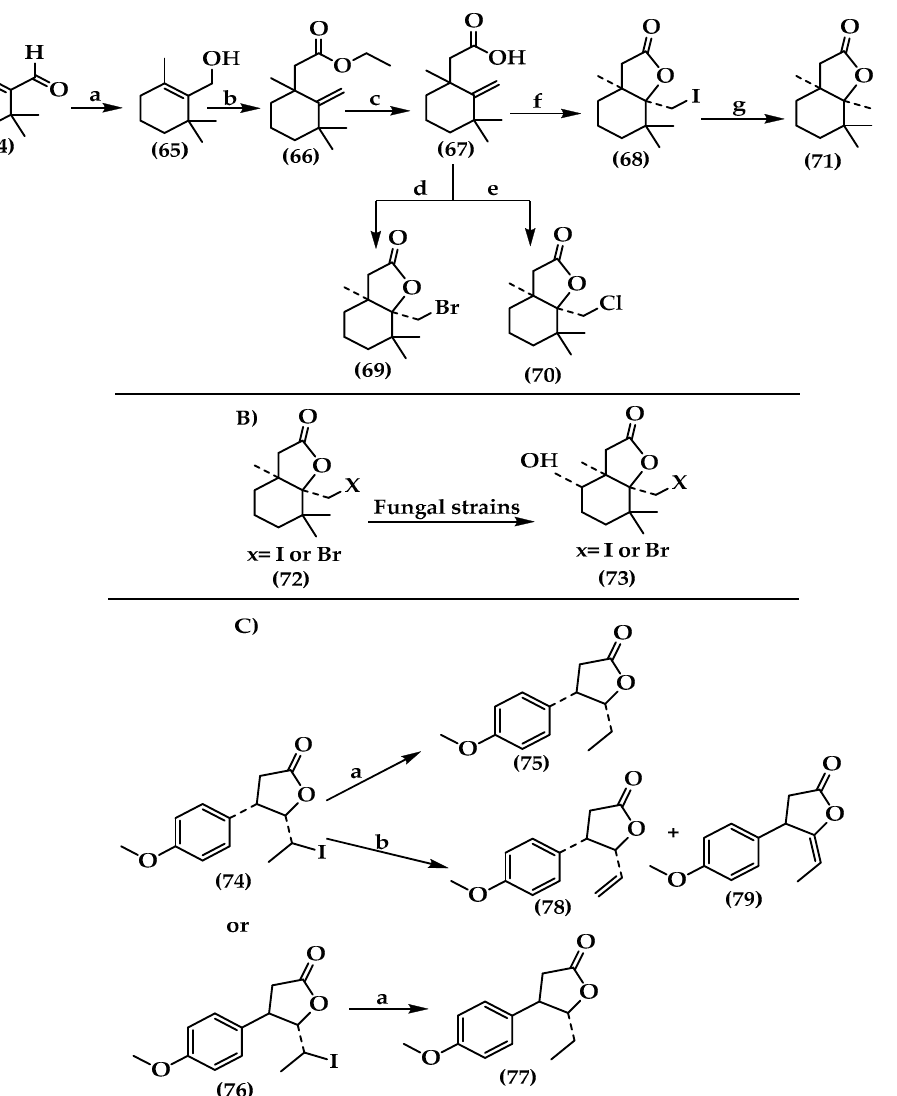
Scheme 1. Synthesis of series of lactones derivatives from β -cyclocitral ( A ) and halogenated lactones ( B , C ). Reagents and condition of ( A ): (a) NaBH 4 ,H 2 O/CH 3 OH, rt., 3 h, 97%; (b) CH 3 C(OC 2 H 5 ) 3 ,